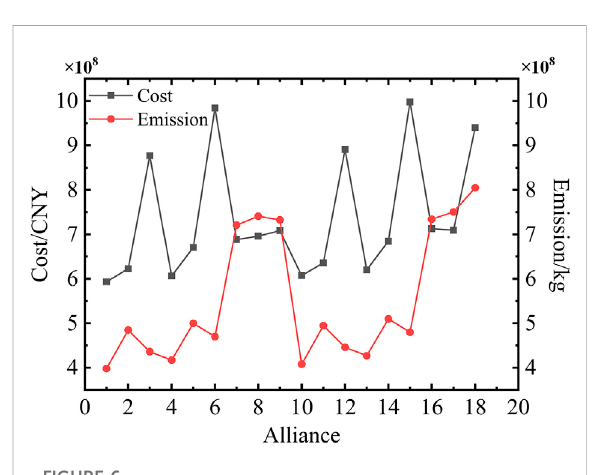
FIGURE 6 Optimization results for all sub-af fi liate operations.